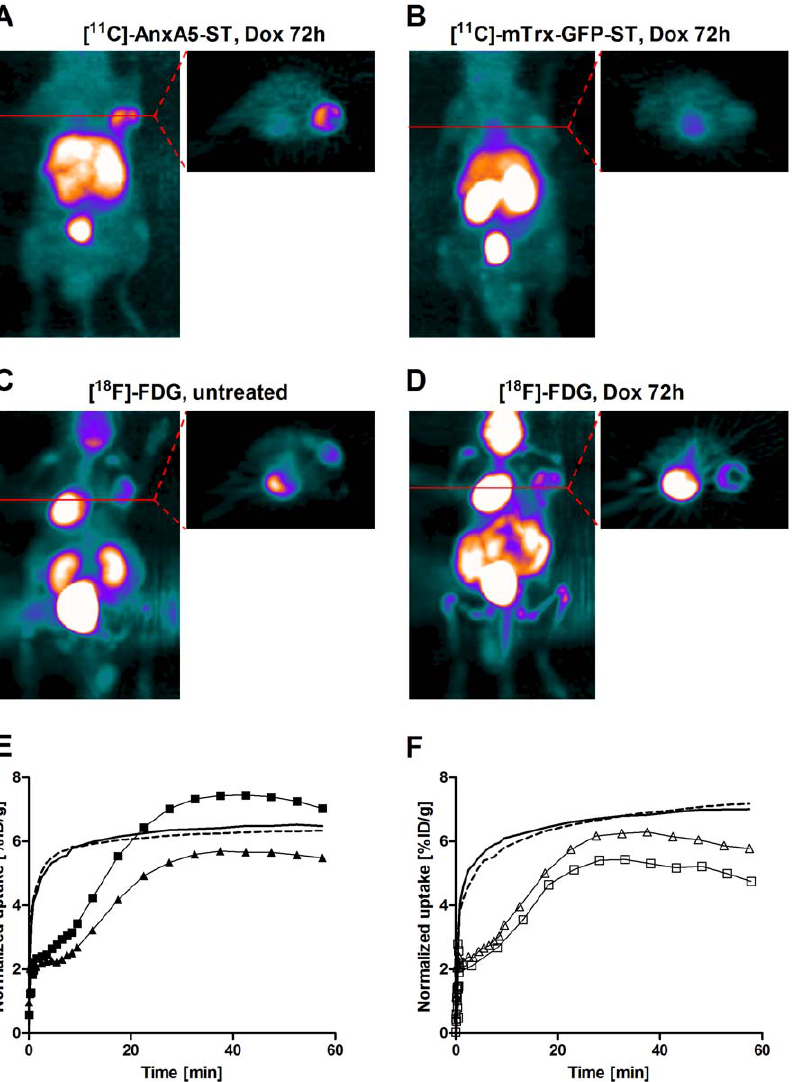
[ 11 C]-mTrx-GFP-ST, 72 h after treatment with a single dose of doxorubicin (5 mg/kg). Also shown are representative images of [ 18 F]-FDG, at C ) baseline or, alternatively, D ) after treatment with doxorubicin and 90 min after the image with [ 11 C]-AnxA5-ST in A ) . E ) Time activity curves of single tumors showing uptake of [ 11 C]-AnxA5-ST (solid triangles and squares) or [ 18 F]-FDG (lines) before (solid triangle and dashed line) or after doxorubicin treatment (solid squares and solid line). F ) Corresponding experiments showing a comparison between of [ 11 C]-mTrx-GFP-ST (empty triangles and squares) and [ 18 F]-FDG (lines) tumor uptake in the same mouse before (empty triangles and dashed line) or after doxorubicin treatment (empty squares and solid